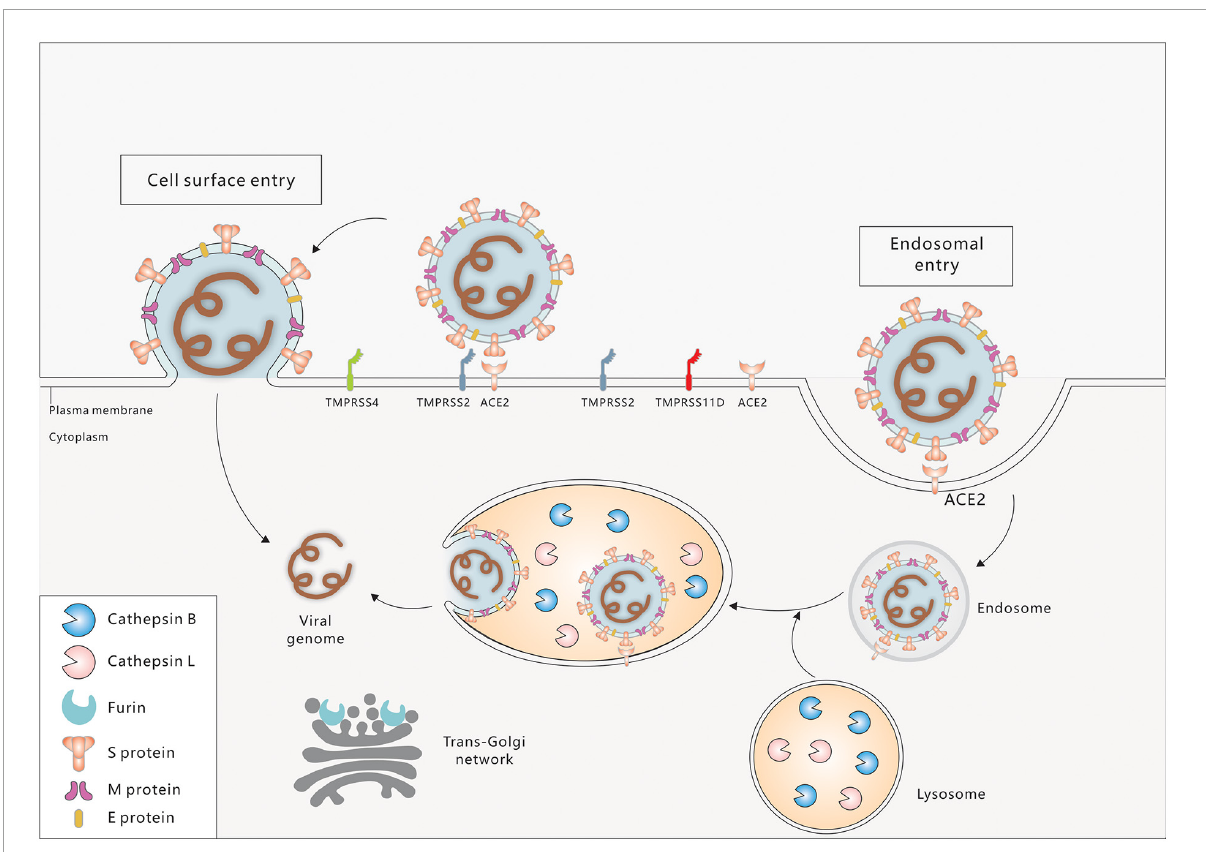
FIGURE2 Cell entry mechanisms of SARC-CoV-2. Spike protein (S), envelope protein (E), and membrane protein (M) are three major proteins on the membrane of SARS-CoV-2. Cell surface entry and endosome entry are two distinct SARS-CoV-2 entry mechanisms. ACE2 is the primary receptor for SARS-CoV-2 entrance into the oral cavity. Virus binding to ACE2 triggers the conformational changes of the S1 subunit, exposing the S2’ site, which is then cleaved by the membrane protease TMPRSS2/4/11D (Cell surface entry pathway). In the absence of TMPRSS2, ACE2-virus complex is internalized via endocytosis into endosome/endolysosome where the S2’ site is cleaved by Cathepsin B/L (Endosome entry pathway). The fusion peptide is exposed and fuses with the cell membrane. The viral genome is then released into the cytoplasm of the host cell. In the virus producing cell, Furin cleaves the S1–S2 boundary in the trans- golgi network, contributing to the virus assembly and